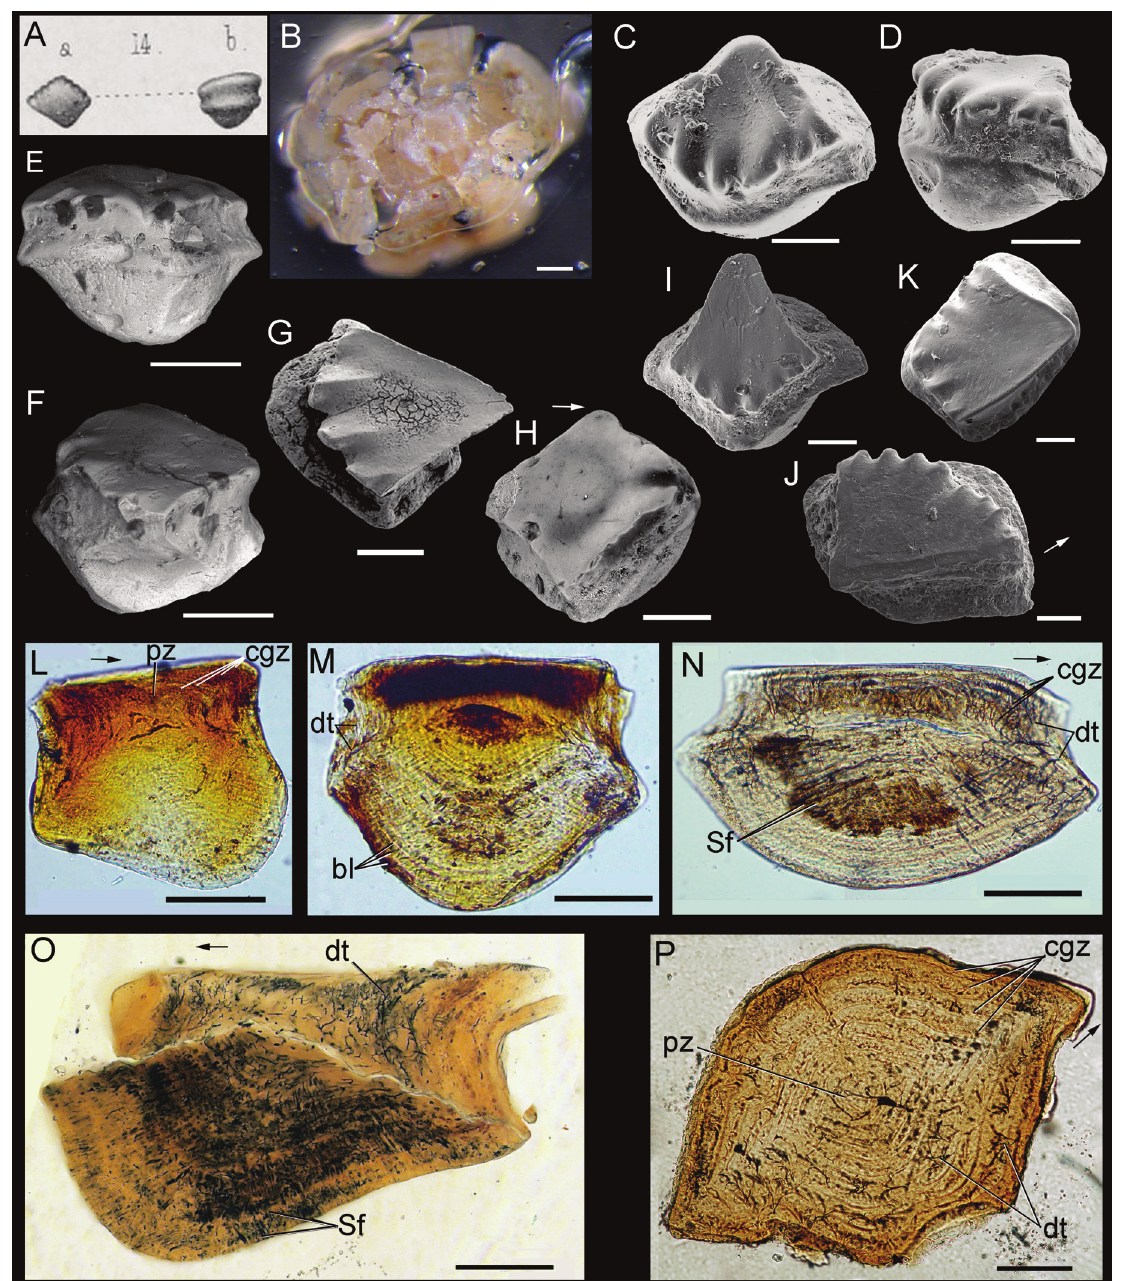
Fig. 3. Gomphonchus volborthi (Rohon, 1893). A , type scale as illustrated by Rohon (1893, pl. 1 fig. 14); B , lectotype PIN 3257/35, imbedded in Canada Balsam, covered with a glass slide, scale now squashed; C – F , scales from the Ludlow Bone Bed (early P ř idoli), Ludlow, Shropshire, England: C–D, neotype scale NHMUK PV F63947 crown and anterolateral views (Vergoossen 1999a, fig. 11); E, scale NRM-PZ P 17054, anterior view; F, scale NRM-PZ P 17055, laterocrown view; G , scale NRM-PZ P16360 from G00-26LJ, upper Hamra Formation, Ängvards, Gotland (Bremer et al. 2019b, fig. 10M); H , RGM.1333566 from JV84 erratic, Netherlands; I , scale GIT 845-31 from the Suurlahe-738 core , depth 12.0–12.13 m; J , scale GIT 845-29 from the Kingissepa core, depth 21.20– 21.30 m; Uduvere Beds, Paadla RS (Ludfordian, Ludlow); K , scale GIT 845-41 from the Tahula Beds, Kuressaare RS; L , M , sections of scales from the Ludlow Bone Bed, probably at Ludlow, Shropshire, England: L, vertical longitudinal section NRM-PZ SI 3501; M, vertical transverse section NRM-PZ SI 3502; N , vertical longitudinal section of scale RGM.1333567 from erratic JV84, Netherlands; O , P , sections of scales from the Laadjala Bridge outcrop, Saaremaa; Tahula Beds of the Kuressaare RS (Ludfordian, Ludlow): O, vertical longitudinal section GIT 845-37; P, crown horizontal sections GIT 845-39. Scale bars = 0.1 mm except N and O = 0.2 mm. Abbreviations : bl, base lamellae; cgz, crown growth zones; dt, dentine tubules; pz, primordial growth zone; Sf, Sharpey’s